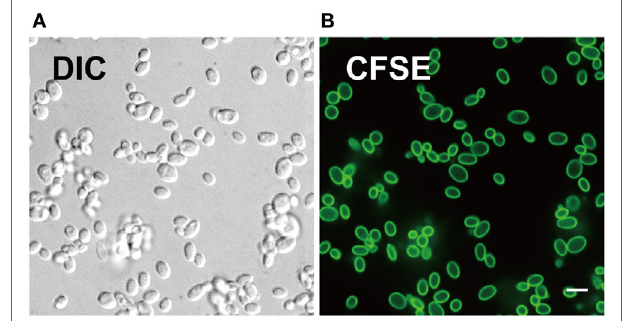
FigUre 1 | Carboxyfluorescein succinimidyl ester (CFSE) labels cell wall of Candida glabrata . (a) Differential interference contrast and (B) fluorescence confocal microscopy image of live C. glabrata stained with CFSE showing labeling of all yeast cells prior to cell division. Scale bar represents 5